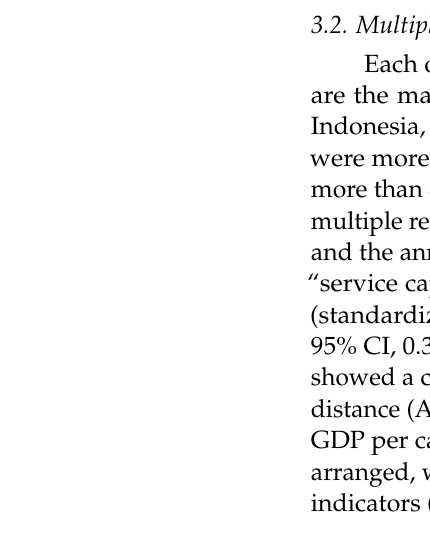
Table 3. Multiple regression analysis of the contribution of each SCI component to SCI displacement (based on the annual rate of